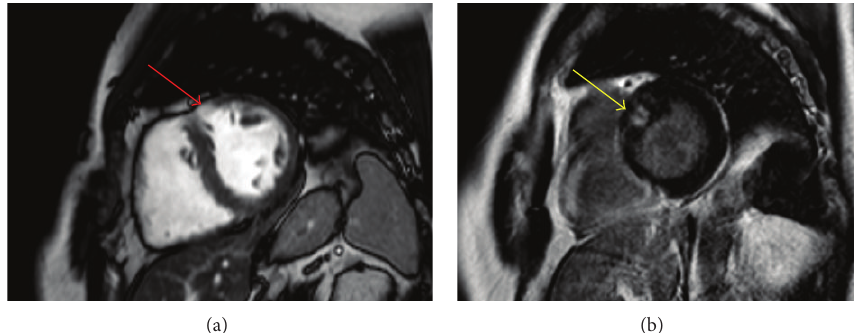
Figure 3: Cardiac magnetic resonance short-axis imaging of the patient presented in the case. (a) CMR short-axis cine image with the myocardial crypt (red arrow) in the anteroseptal segment on the left. (b) CMR short-axis image delayed enhancement in the anteroseptal segment with mid wall fibrosis (yellow arrow). Images (a) and (b) are not oriented in the same slice position due to image